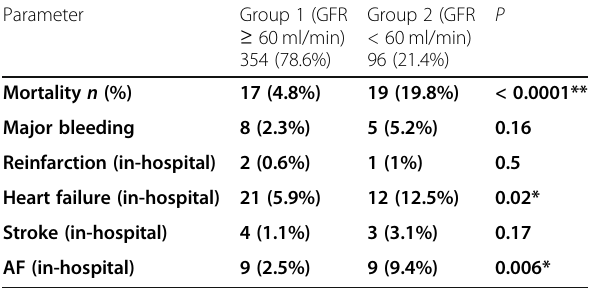
Table 3 Frequencies of different outcomes compared